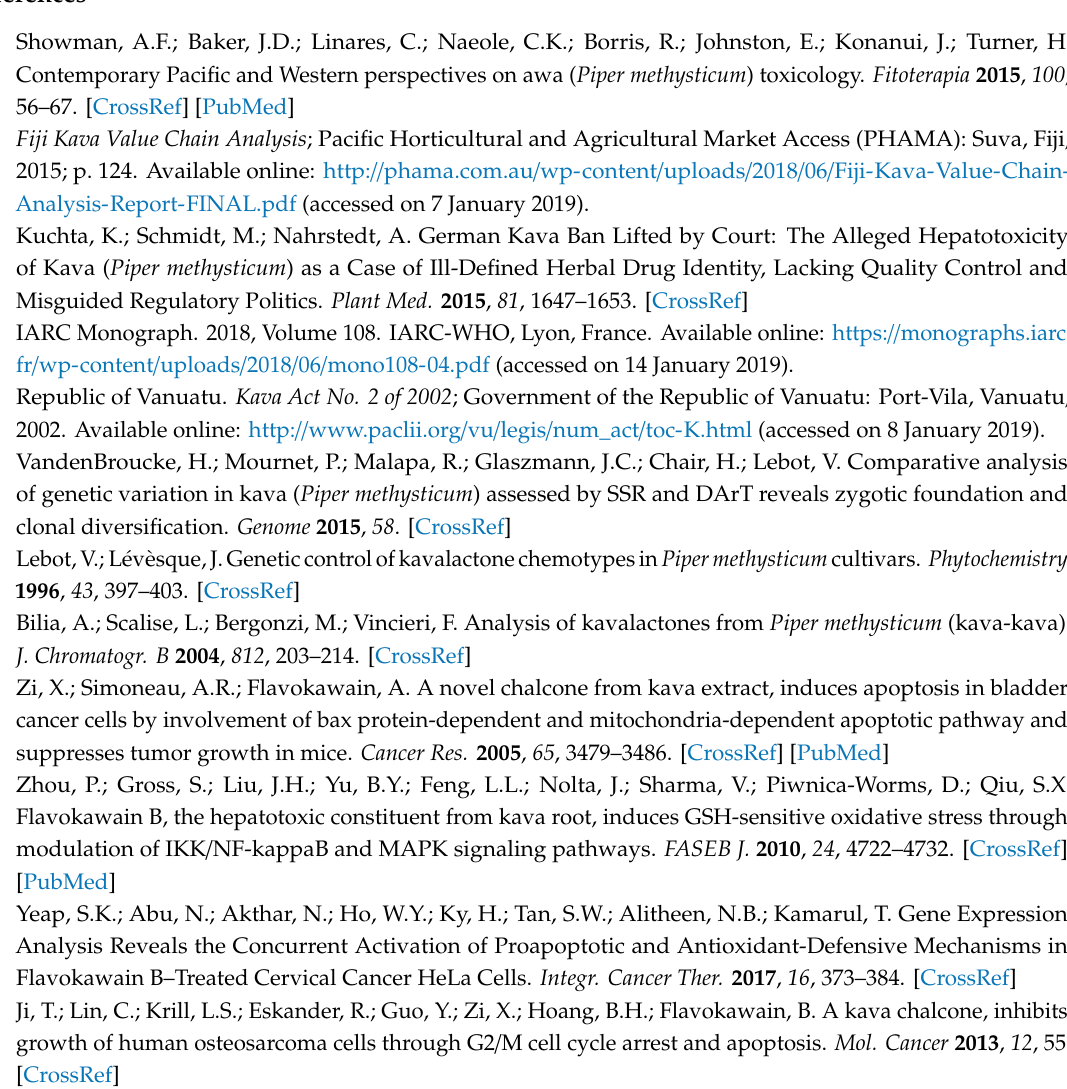
Table S1: List of varieties